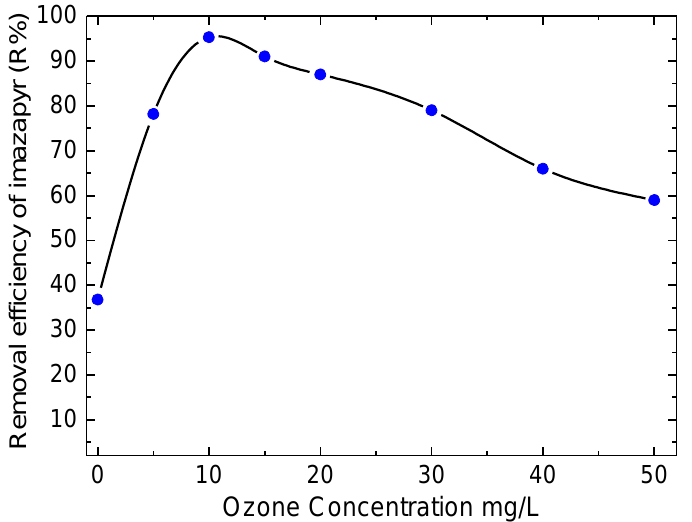
Figure 6. Removal efficiency of imazapyr under variation of ozone concentration. C (Imazapyr) = 5 μΜ; C TiO2 = 100 mg L −1 ; stirring speed = 1000 min −1 , aqueous suspension Milli-Q water.